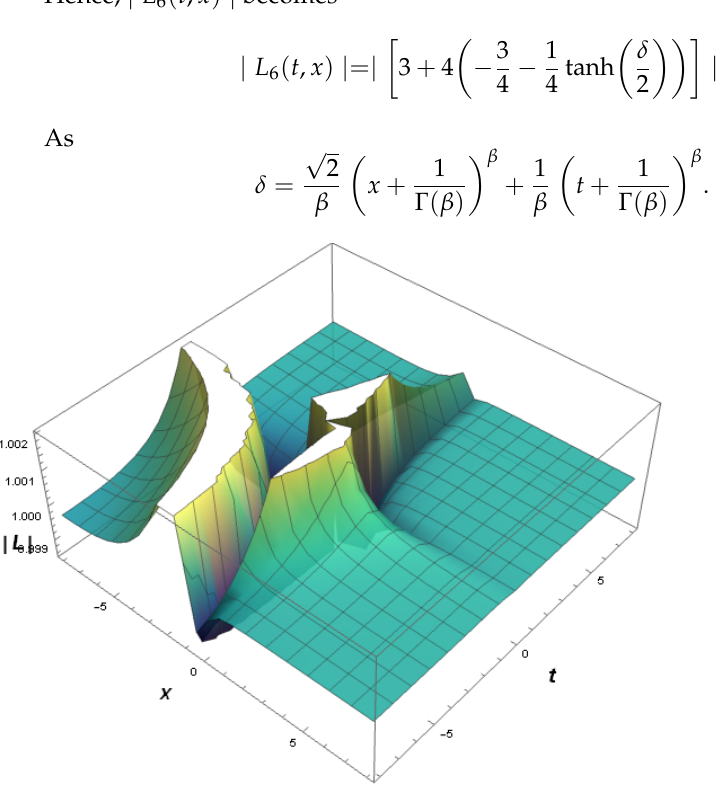
Figure 5. The 3D graph of dark solitary-wave solutions, i.e., | L 6 | across β = 0.3. Figure 6: This illustration portrays a realistic representation of | L 10 ( t , x ) | which is linked to the category of dark, singular solitary-wave solutions. Here is a visual showing a 3D plot spanning the range ( − 0.5, 0.5 ) for various values of β associated with parameters, √ , µ 1 = 1, ζ 1 = 2, ν 1 = 3, β = 0.3. such as ρ = e , l = 2, c = 1, α = − 1, s 1 = 1 2 Hence, | L 10 ( t , x ) | becomes